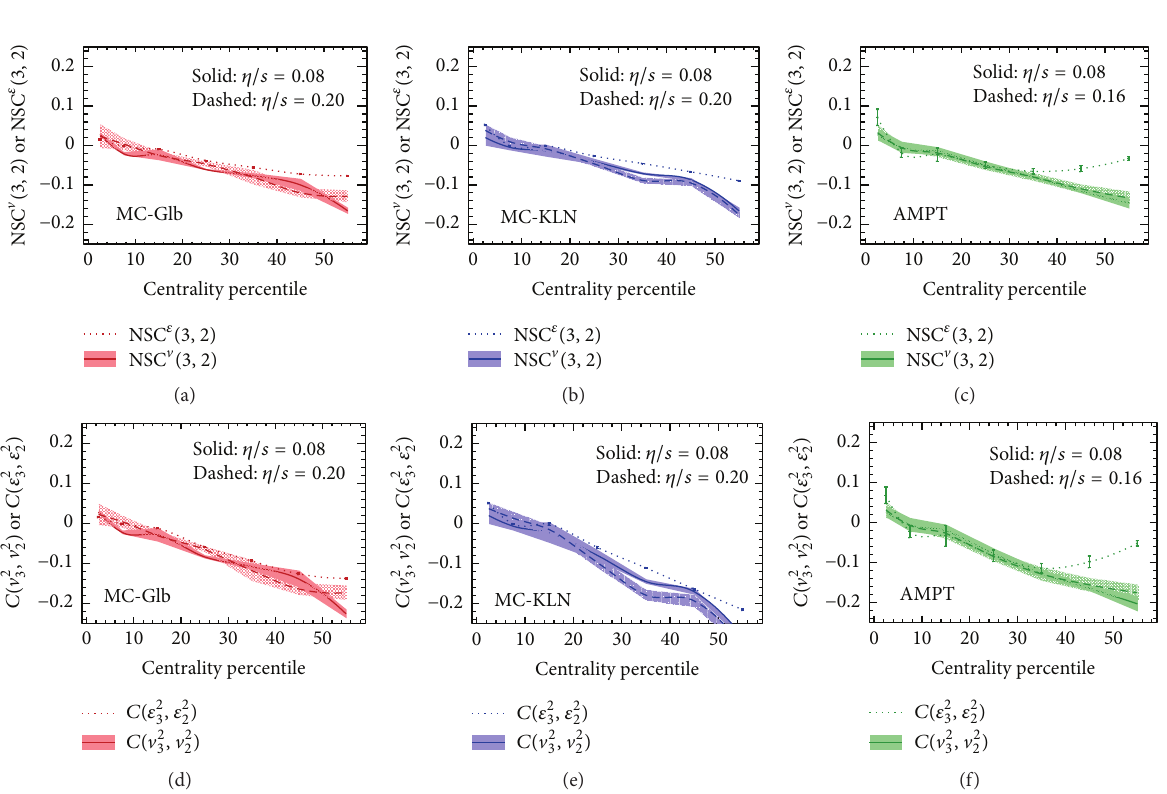
Figure 9: The centrality dependence of NSC (3,2) (a, b, and c) and 𝐶( V 2 3 , V 2 2 ) (d, e, and f) and the corresponding observables in the initial conditions at √𝑠 NN = 2.76 TeV Pb–Pb collisions from VISH2+1. Figures are taken from